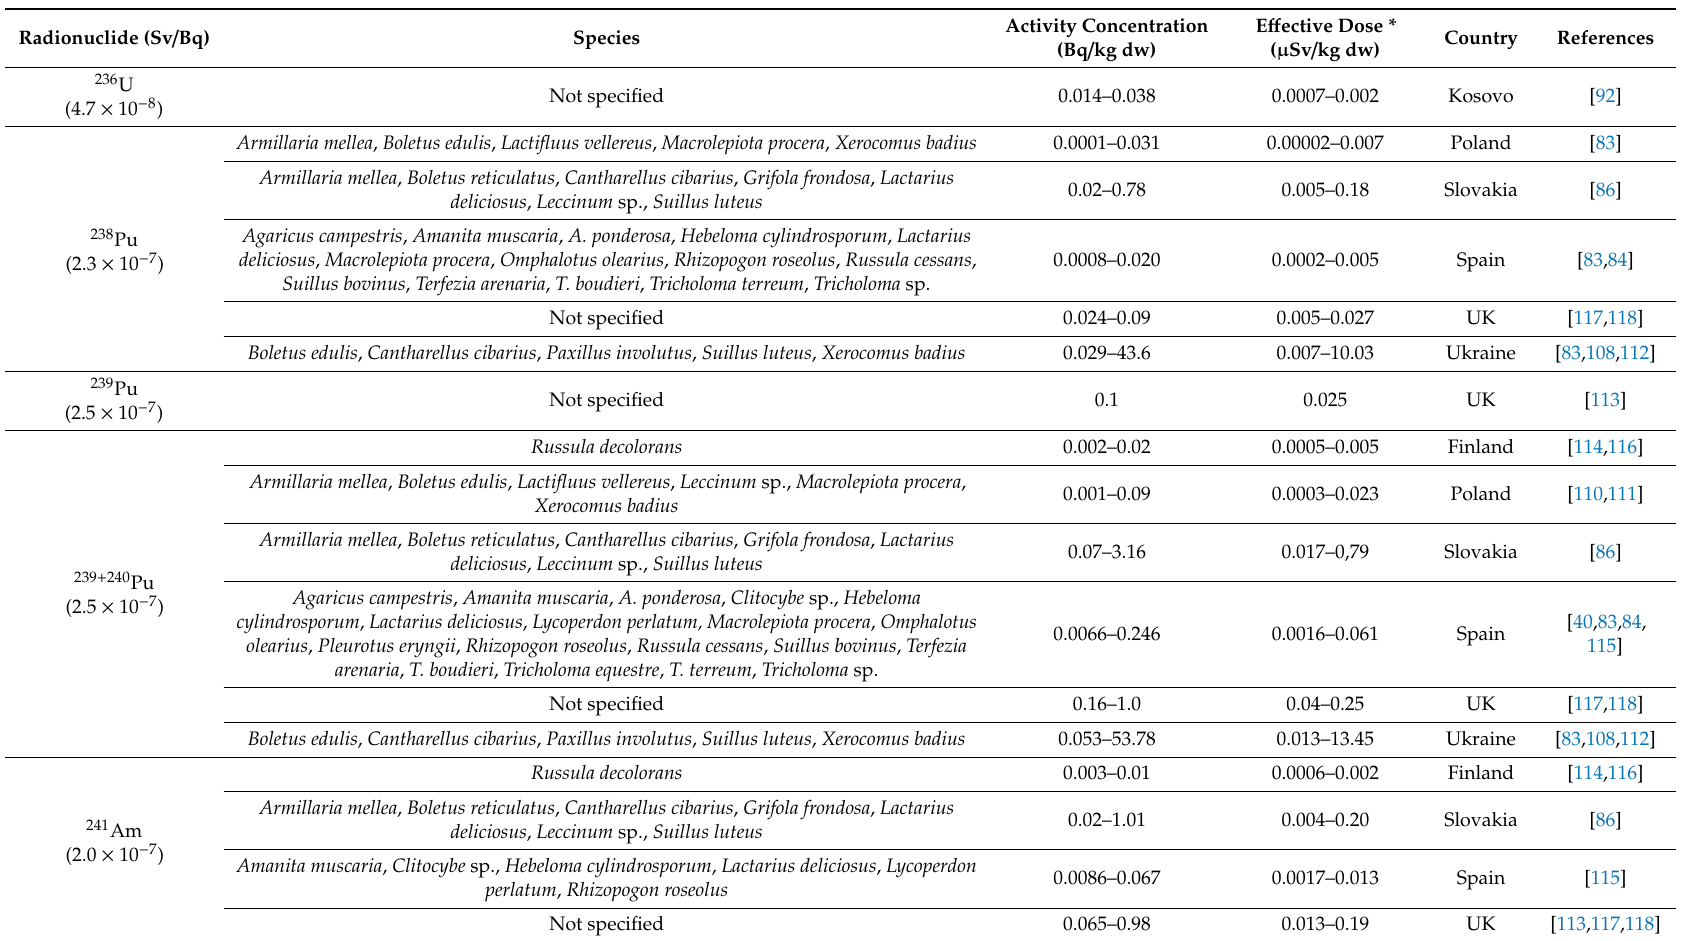
Table 2. The activity concentration ranges of anthropogenic alpha-emitting radioisotopes in wild-growing mushrooms (the Latin names of the species are cited as described by the authors—the current names of some species can be found on the Index Fungorum web site) collected from a di ff erent countries as well as the e ff ective dose from mushrooms consumption presented as a proportion of total dietary consumption ( µ Sv / kg dw) (* calculation based on the isotopic activity concentration and e ff ective dose coe ffi cients (Sv / Bq) for ingestion of radionuclides for adults